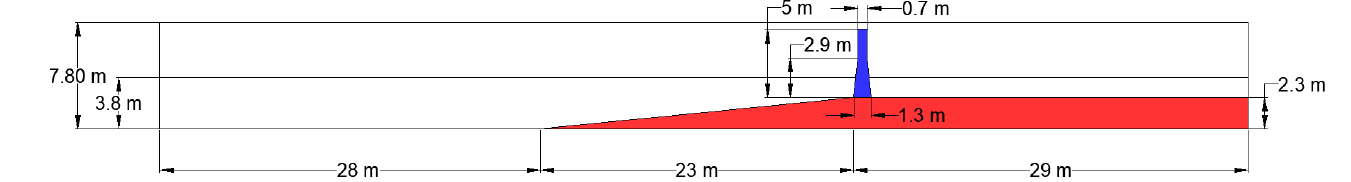
Figure 1. Schematic representation of the Numerical Wave Tank (NWT) with the two vertical cylindrical substructures: front view ( top ); top view ( bottom ).